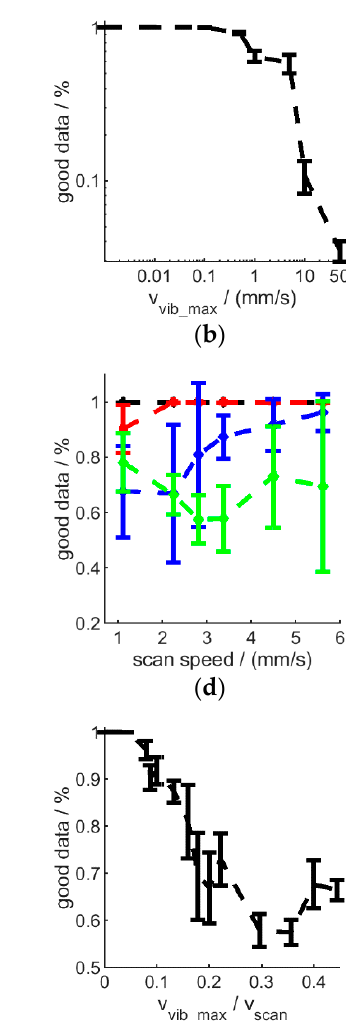
Figure 11. The effect of vibrating sample on noise ( a ) and data quality ( b ) for various vibration frequencies and amplitudes. The standard deviation is shown by the single-sided positive error bars.